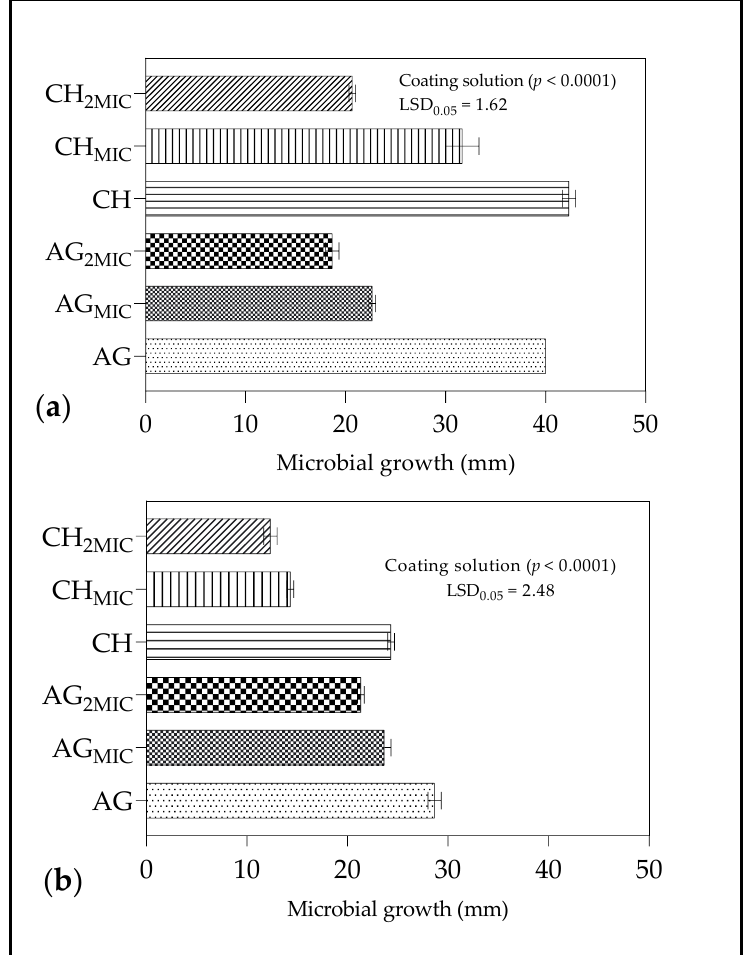
Figure 5. Effect of coating solutions on zone of inhibition (mm) produced after inoculation with spore suspension (1 × 10 9 spores·L −1 ) of ( a ) Botrytis cinerea and ( b ) Penicillium spp; MIC—minimum inhibitory concentration; 2MIC—double the minimum inhibitory concentration. B. cinerea (MIC = 15 µL/mL; 2MIC = 30 µL/mL) and Penicillium spp. (MIC = 30 µL/mL; 2MIC = 60 µL/mL); CH—chitosan; CH MIC —chitosan formulated with lemongrass oil at minimum inhibitory concentration (15 or 30 µL/mL); CH 2MIC —chitosan formulated with lemongrass oil at double the minimum inhibitory con- centration (30 or 60 µL/mL); AG—sodium alginate; AG MIC —sodium alginate formulated with lemongrass oil at minimum inhibitory concentration (15 or 30 µL/mL); AG 2MIC - sodium alginate for- mulated with lemongrass oil at double the minimum inhibitory concentration (30 or 60 µL/mL). Vertical bars represent the standard error (SE) of mean values of three replicates (1 plate = replicate). LSD 0.05 represent least significant difference ( p < 0.05).